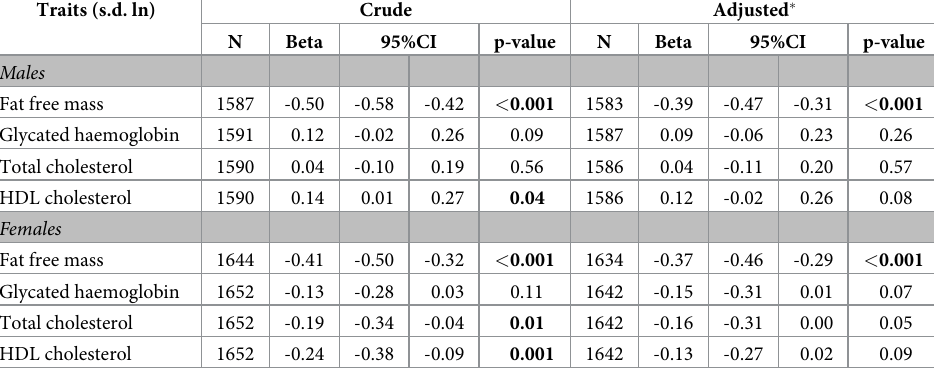
Table 5. Associations of stunting at age 2 years with glycated haemglobin, total cholesterol and HDL cholesterol, and fat free mass at age 30 years by sex. Traits (s.d. ln) Crude Adjusted (cid:3)